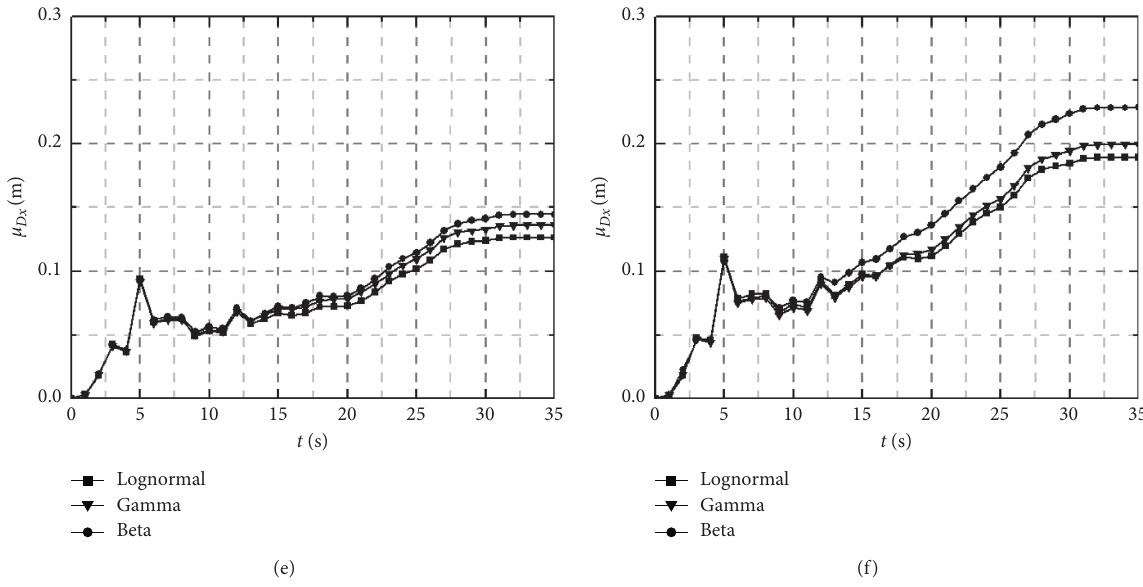
� 6m and CoV � 0.1; (b) D x ) with different distributions: (a) δ x G